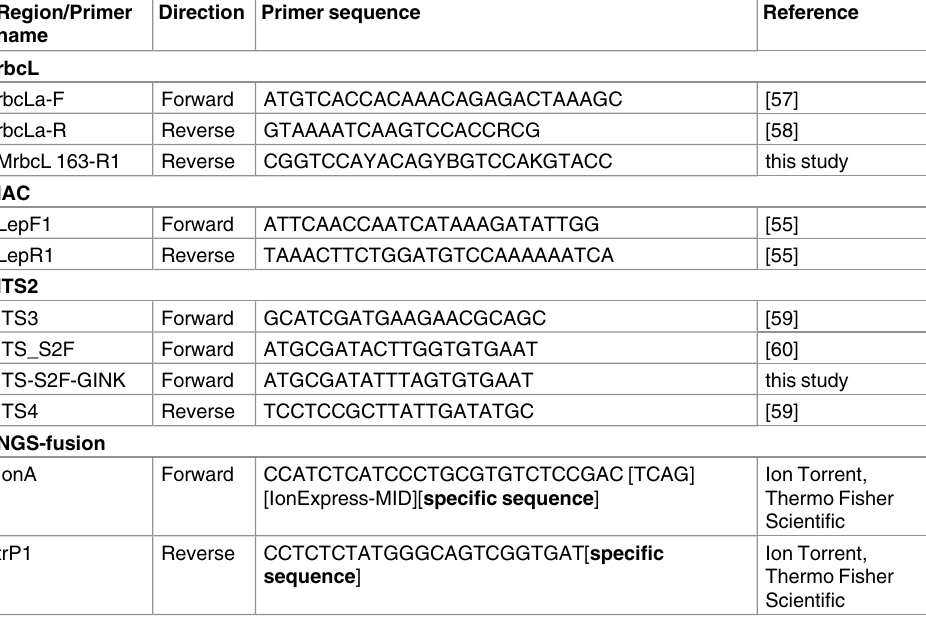
Table 2. Primers used for Sanger sequencing, NGS and in